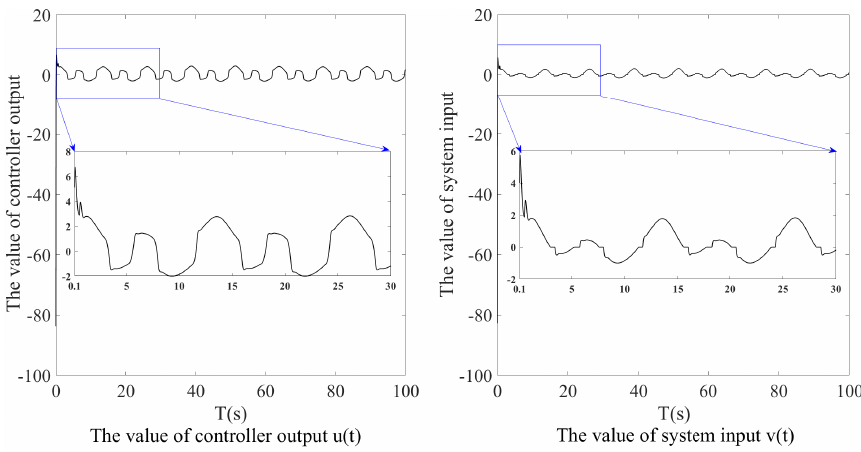
Figure 16. Controller output curve and system input curve in the case of a chemical